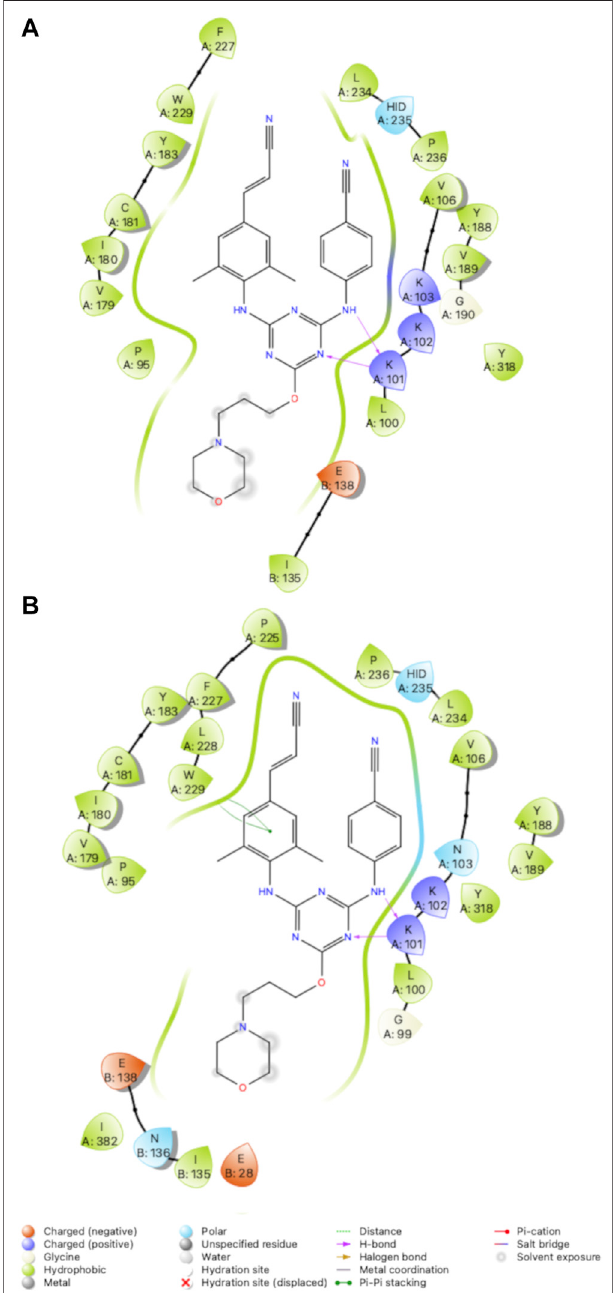
FIGURE 7 | 2D Interaction diagramsforRT (Y181C): Compound 2(A) and RT(K103N/Y181C):Compound 2(B) .Compound2retainshydrogenbondswith K101 and van der Waals contacts with several residues for both variants. Hydrogen bonds are represented by purple arrows; π - π interactions are represented by green lines between aromatic rings and residues; van der Waals contacts are made between all listed residues within a radius of 4 Å. The key provided below speci fi es residue type, water molecules, and